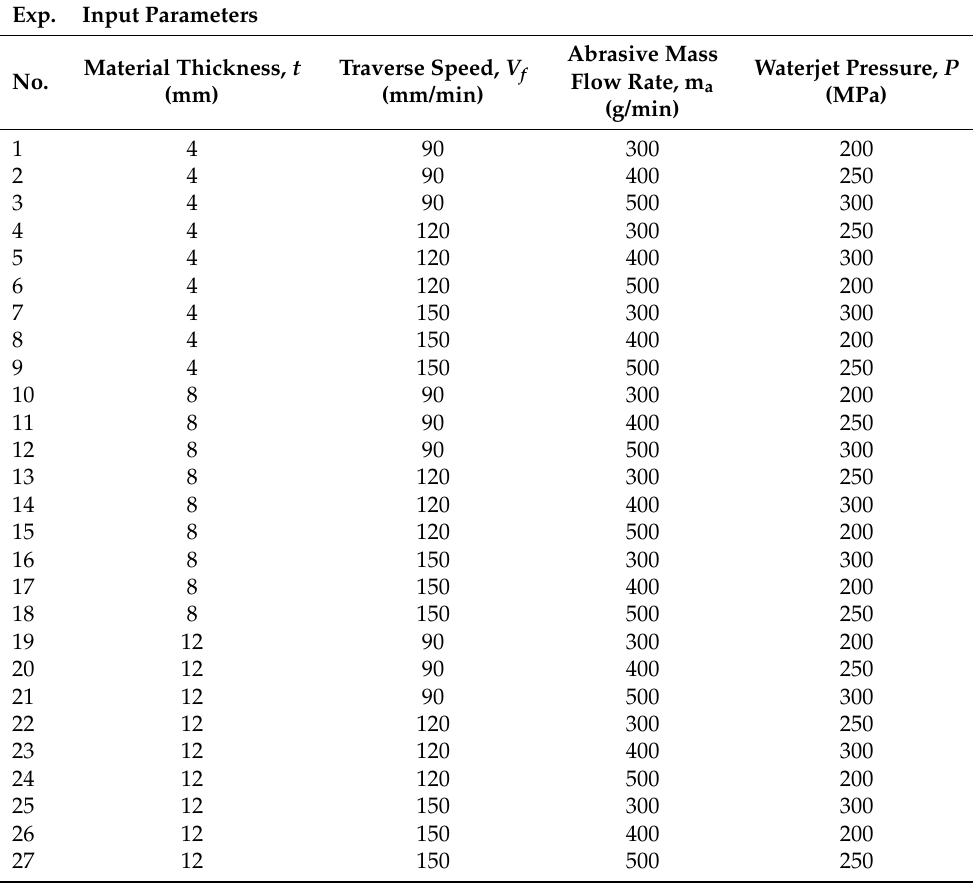
Table 4. The L 27 orthogonal array of